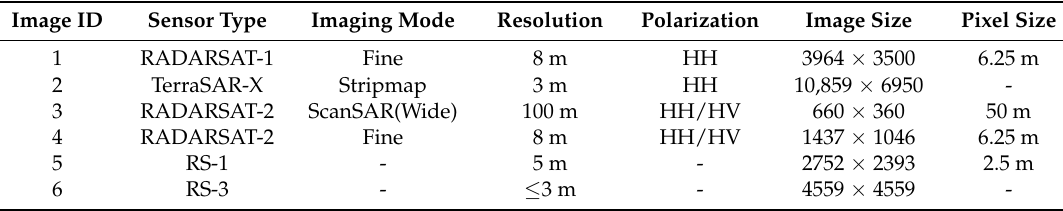
Table 2. Experimental data and their parameters.